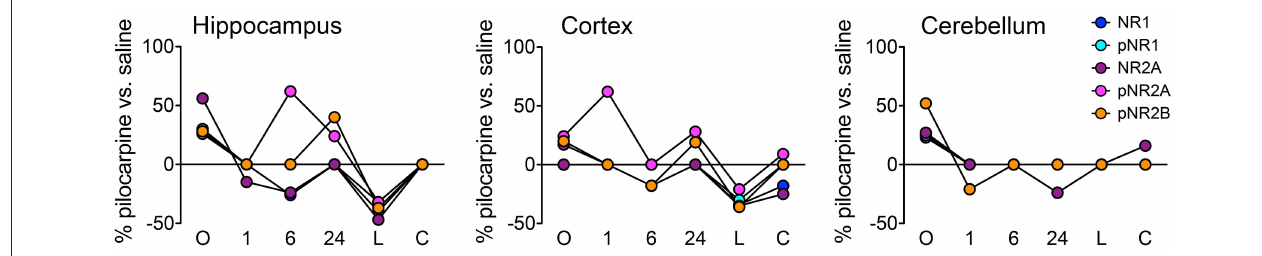
FIGURE 2 | Time course of expression changes for NMDA receptor subunits. Percent changes in protein levels in pilocarpine vs. saline mice at the corresponding time points were obtained using a three-level mixed effects model; data are from Supplementary Table 2 . n = 5 for each group except for chronic pilocarpine where n =